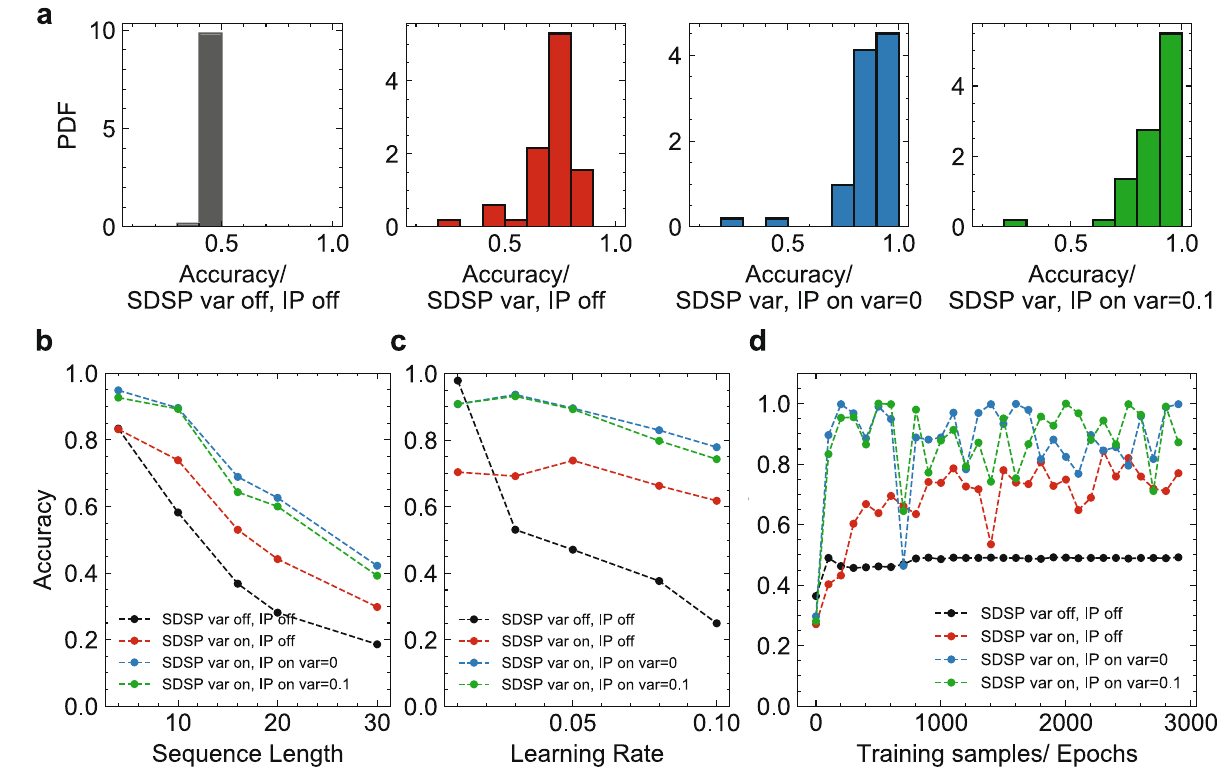
Fig. 5 | Performance of our proposed self-organized network (MEMSORN) under four different cases of variability in the device models: (i) No variability indevices,andIPoperationisoff(black),(ii)Variabilityindevicesreceivingthe SDSP, and IP operation is off (red), (iii) Variability in devices receiving the SDSP, and IP operation is on without variability (Blue), and (iv) Variability in bothSDSPandIPlearningwithstandarddeviationfortheIPdevicessetto0.1, takenfromourmeasurements(green).a Histogramofaccuracyfor500networks con fi rms the higher accuracy for the networks that include variability and IP operationcomparedtotheotherconditions. b AccuracyoftheMEMSORNnetwork on the counting task with respect to the sequence length. As the sequence length increases, the network needs to remember increasingly more input symbolsin the